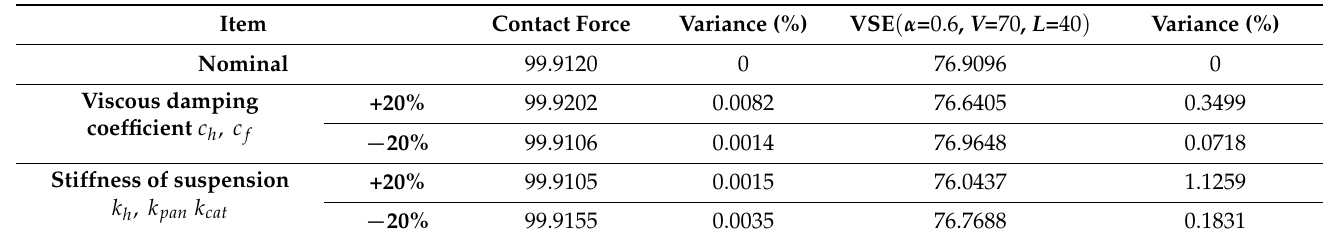
Table 6. Test of performance robustness.